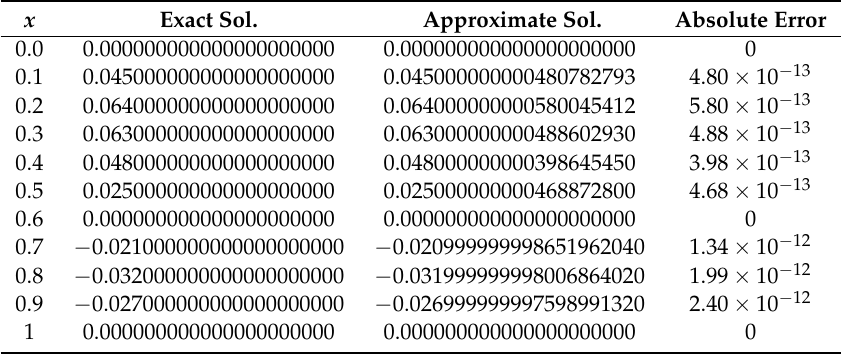
Table 6. Numerical results of Example 2 for m = 5, n = 9 values ( α = 1.75 , β = 0.75). x Exact